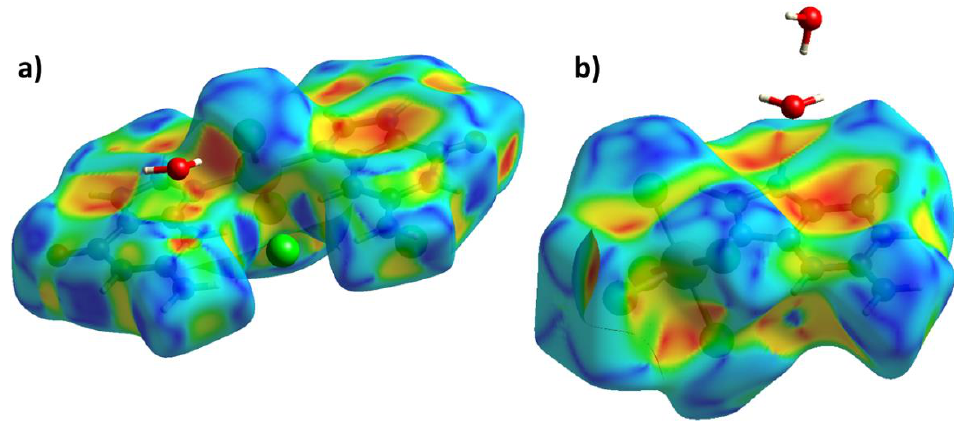
Figure 7. Shape-index of 1 ( a ) and 2 ( b ).